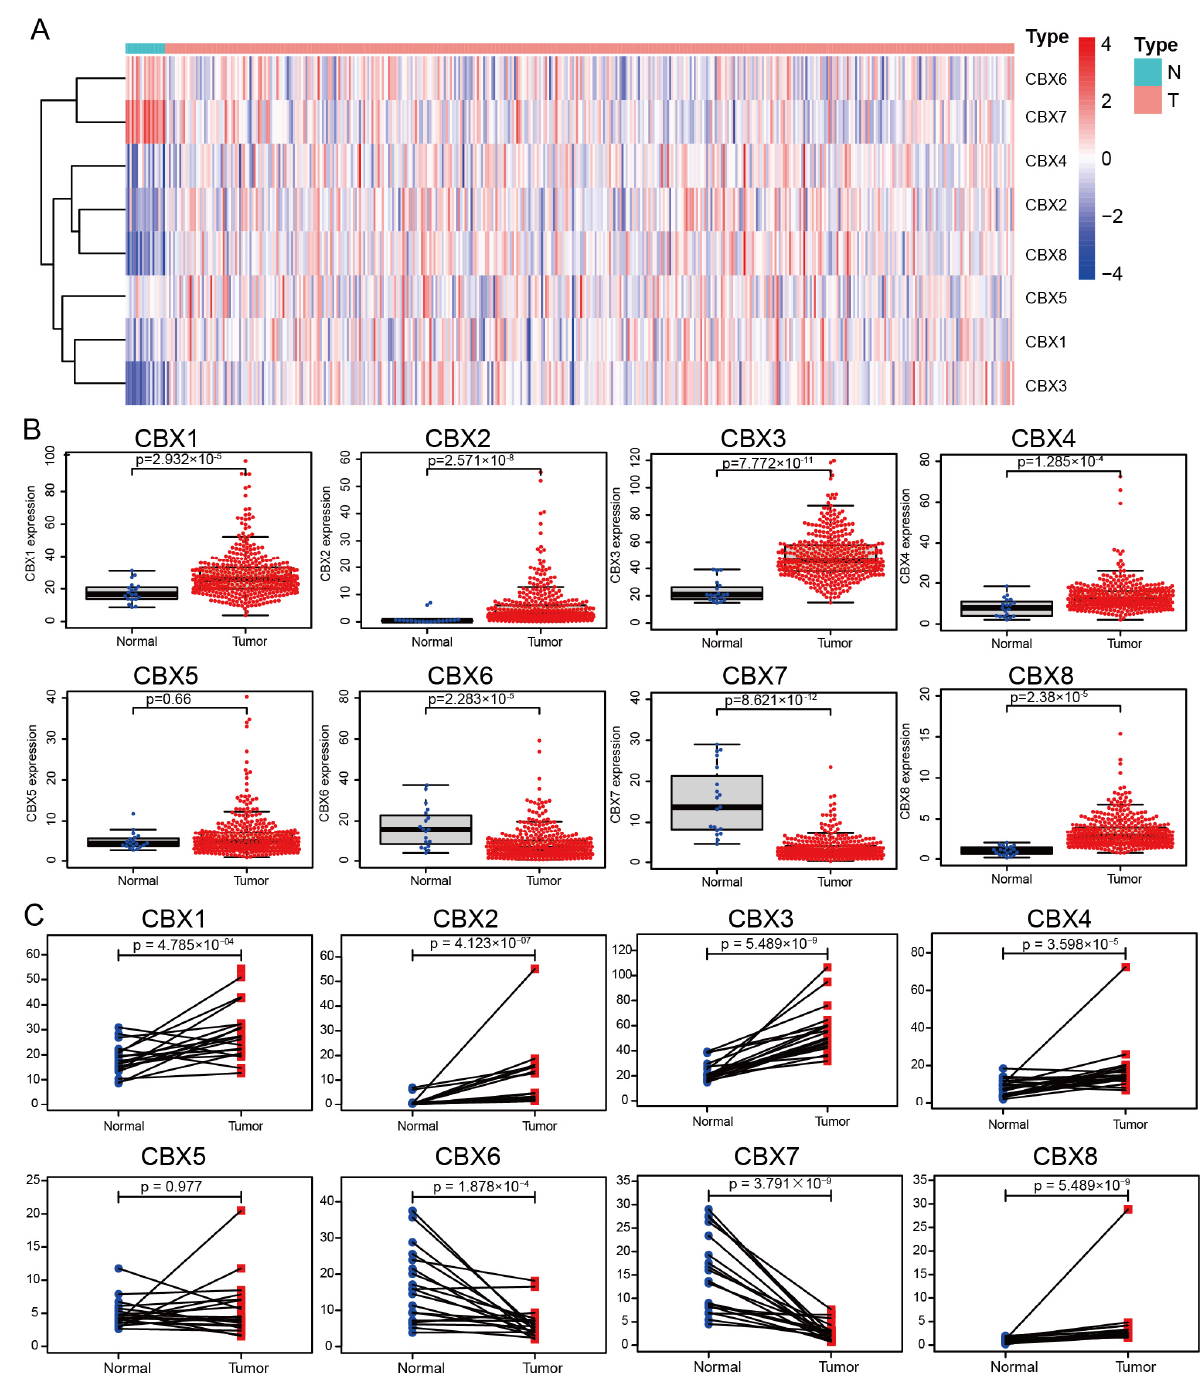
Figure 1. Expression levels of CBX mRNA in BLCA and normal tissues. ( A ) Heatmap depicting CBX mRNA expression in BLCA vs. normal tissues. ( B ) Unpaired samples with 19 normal tissues and 411 BLCA tissues. ( C ) Paired samples comprised 19 normal tissues and their matched BLCA tissues. For statistical analysis, the Wilcoxon rank-sum test was